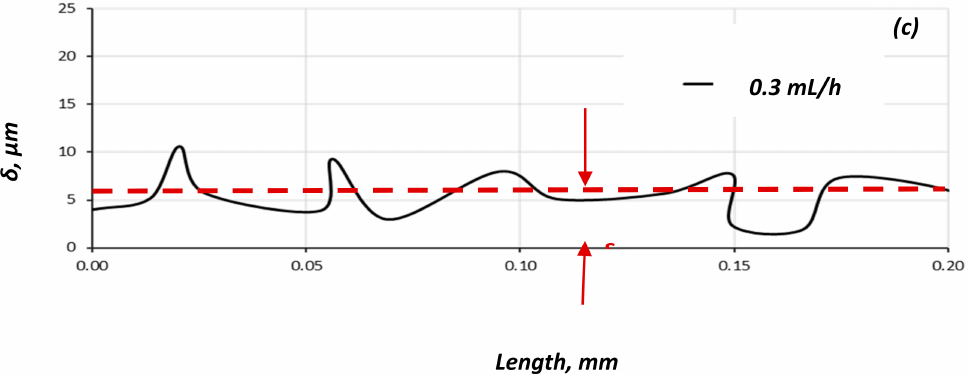
Figure 4. Typical images for: ( a ) Q = 0.5 mL / h; ( b ) Q = 1.2 mL / h. ( D = 100 µ m, H ct = 20%) and ( c ) identification of the CFL boundaries and measurement of its width ( ∆